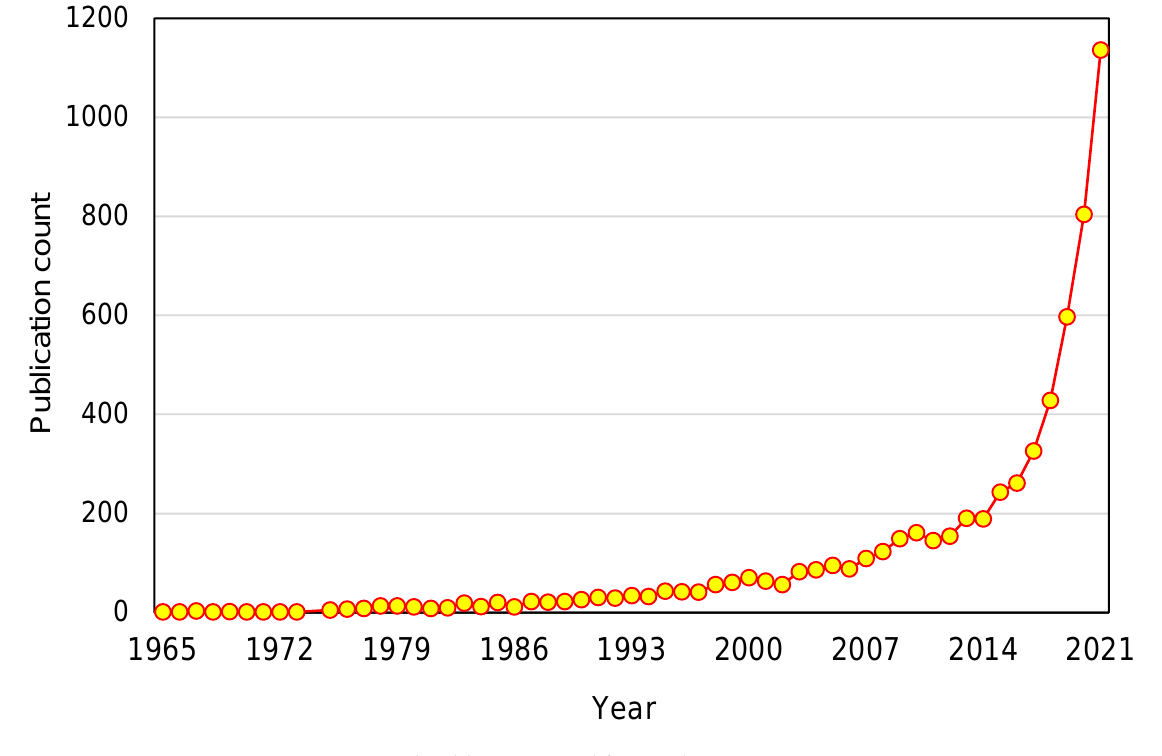
Figure 5. Annual publication trend for articles.